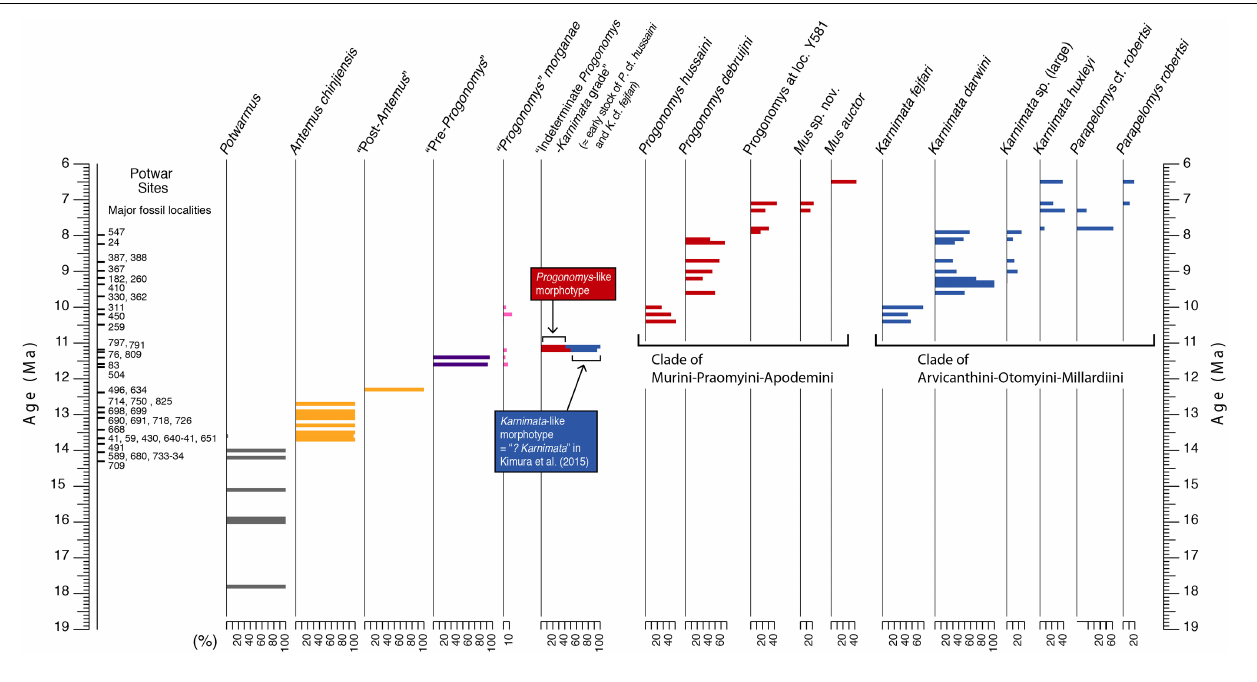
FIGURE 1 | Age and stratigraphic sequence of Potwar Plateau rodent localities of the middle and late Miocene with a time scale in millions of years (Ma); key localities plotted on left. Relative abundances of each taxon and morphotype shown for each stratigraphic level. Pattern reflects evolutionary divergence and diversification of Siwalik Murinae based on species distributions through time. Stem Murinae are succeeded after 11 Ma by crown Murini represented on the one hand by Progonomys and its more derived sister clades (Aghová et al., 2018) and on the other hand by crown Arvicanthini represented by Karnimata and its more derived sister clades. Columns indicate relative abundances among all contemporary murines. The color scheme is maintained in later